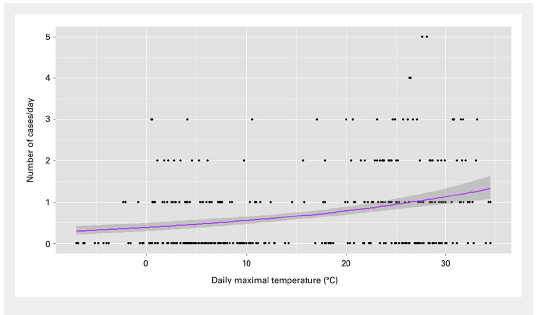
Poisson regression exploring the association between the daily number e of profound hyponatremia cases with maximum daily temperature (°C). Lambda parameter 0.036, p <0.001. Figure was created using R program (the R Foundation for Statistical